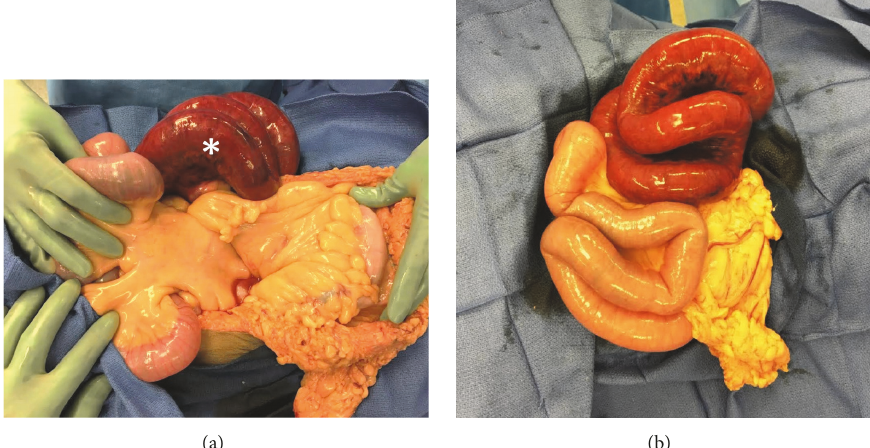
Figure 3: Intraoperative images. (a) and (b) Closed loop obstruction was detected intraoperatively with nonviable bowel ( ∗ ) which was subsequently